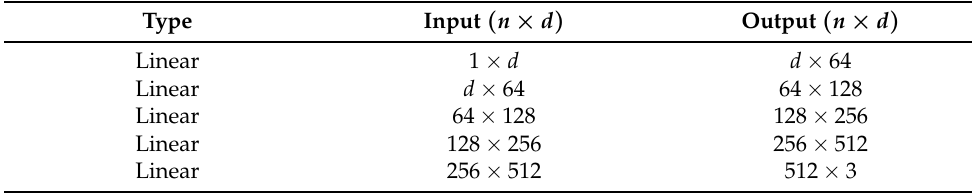
Table 1. DNN architecture for Dataset Base and Dataset Equipment